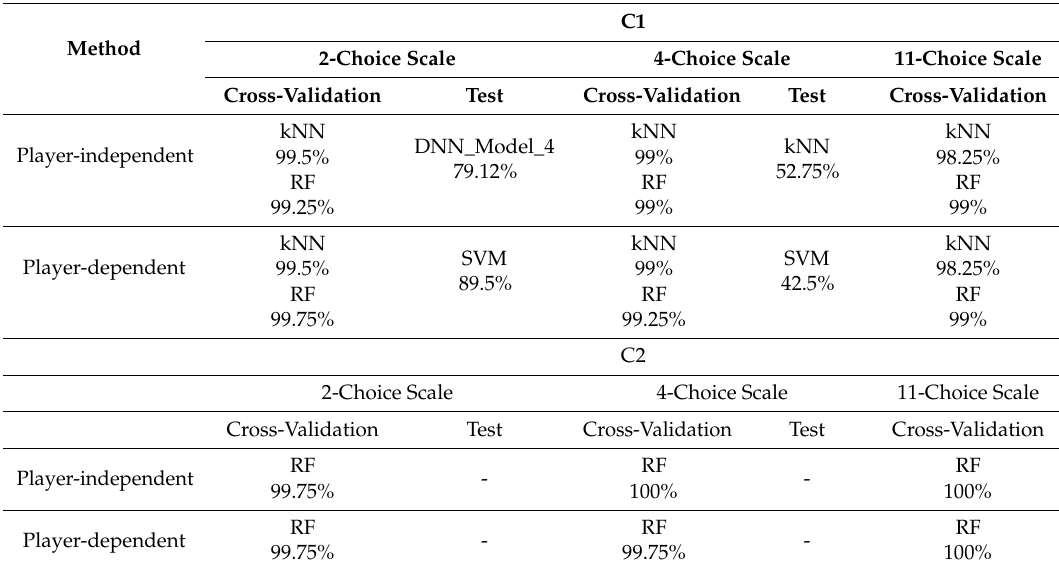
Table 10. Highest cross-validation and test